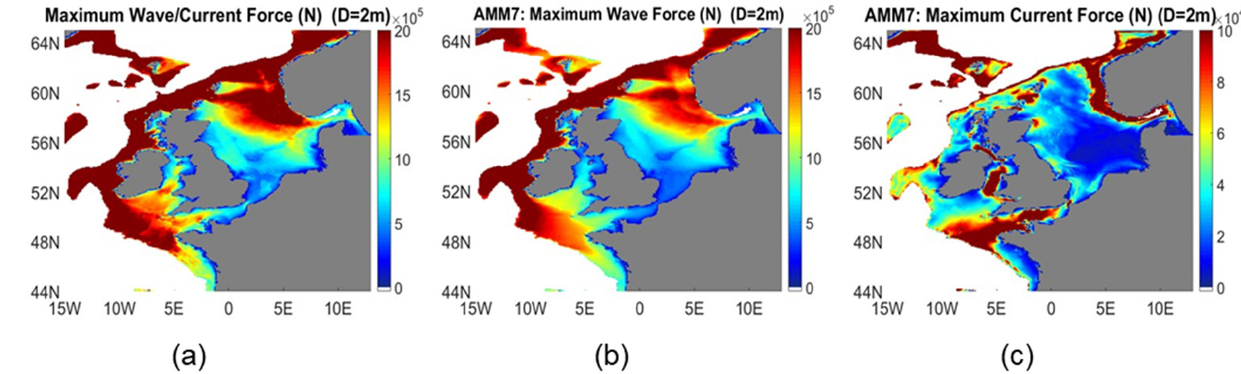
Figure 5. Spatial maps of maximum wave/current force ( a ), wave force ( b ) and current force ( c ), on a pile of diameter D = 2 m, deployment depth up to 500 m, from Met Office FOAM and WaveWatch III model outputs on the AMM7 grid over period July 2014 to June 2016.